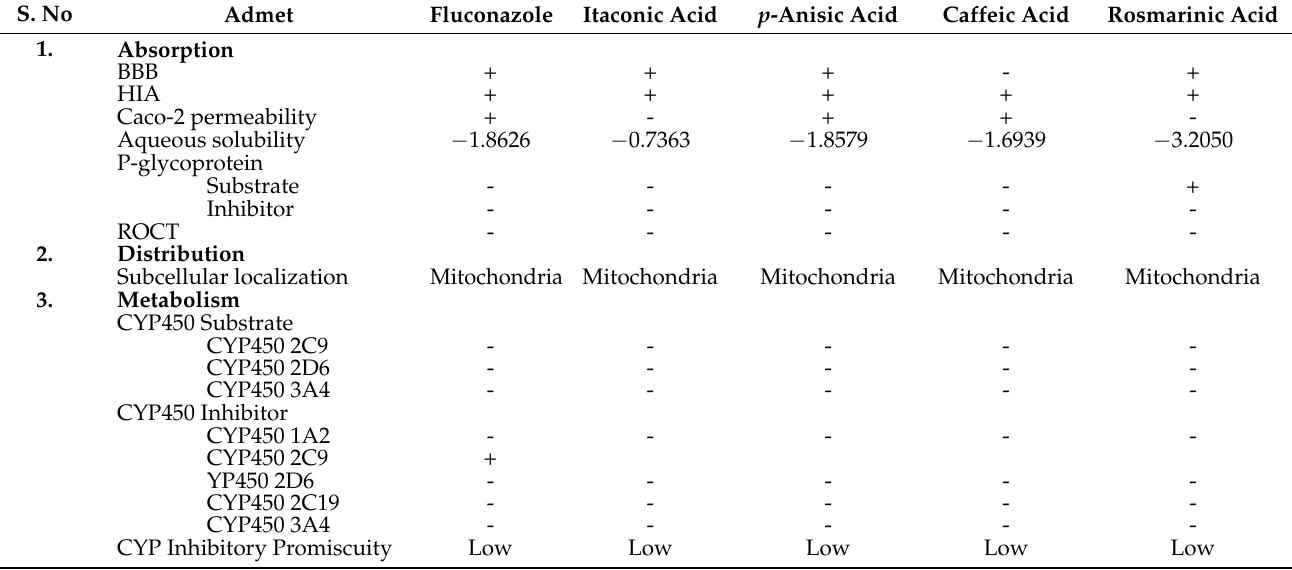
Table 3. ADMET properties of potential ICL 1 inhibitors in C. albicans